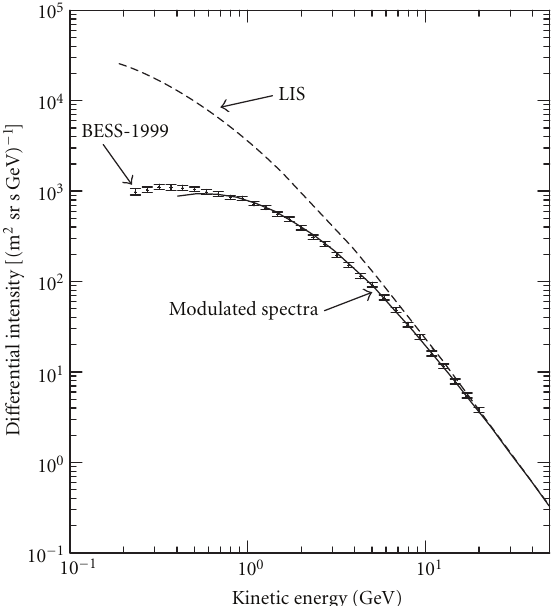
(GeV)10 − 1 Kinetic energy F 7: Proton differential intensity determined with the HelMod code (continuous line) compared to the experimental data of BESS- 1999; the dashed line is the LIS (see the text).